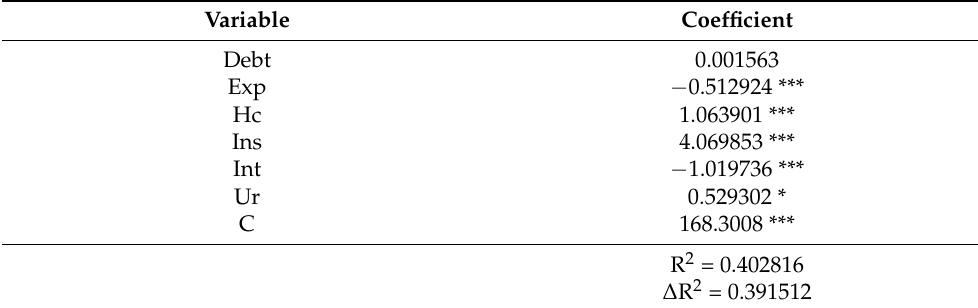
Table 4. The estimation of the parameters for the regression linear model (EU-ALL). Dependent Variable: